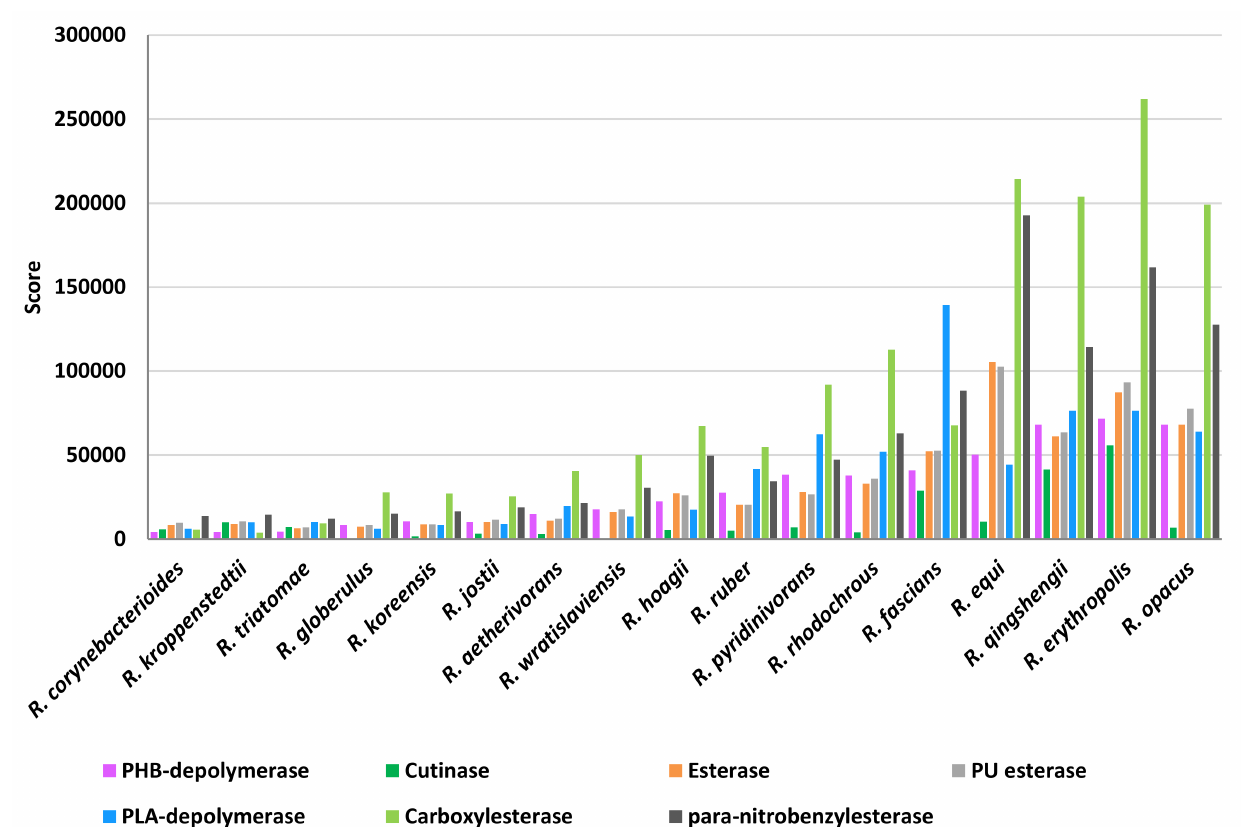
Figure 15. Score values for the most prominent Rhodococcus species for the main enzymatic categories involved in PET, PU, and polyesters